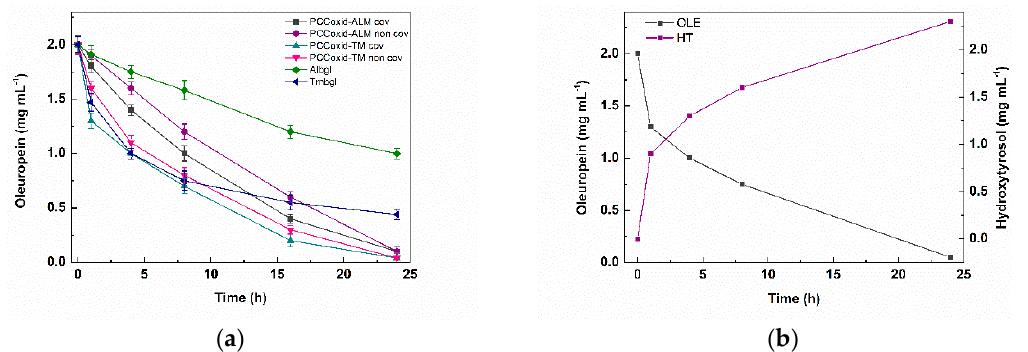
Figure 8. ( a ) Hydrolysis of OLE catalyzed by immobilized β -glucosidase at different time intervals. The amount of the enzyme in the reaction system was 0.15 mg/mL and 0.07 mg/mL for Albgl and Tmbgl respectively. ( b ) Reaction progress of the enzymatic hydrolysis of OLE catalyzed by PCCox-Tmbgl-cov and the formation of HT at different time intervals (the standard deviation was less than 5% in all cases).